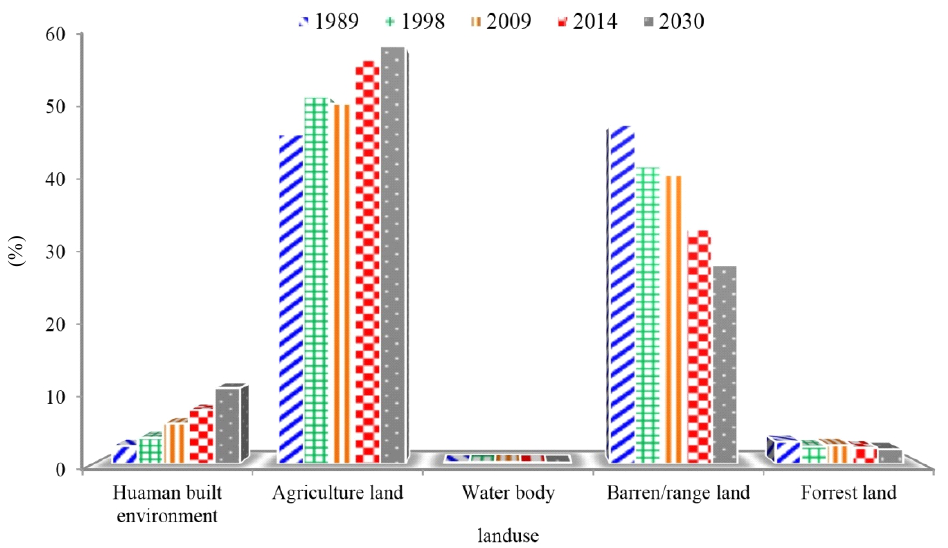
Fig. 8: Area changes of LULCs in study area during the study period